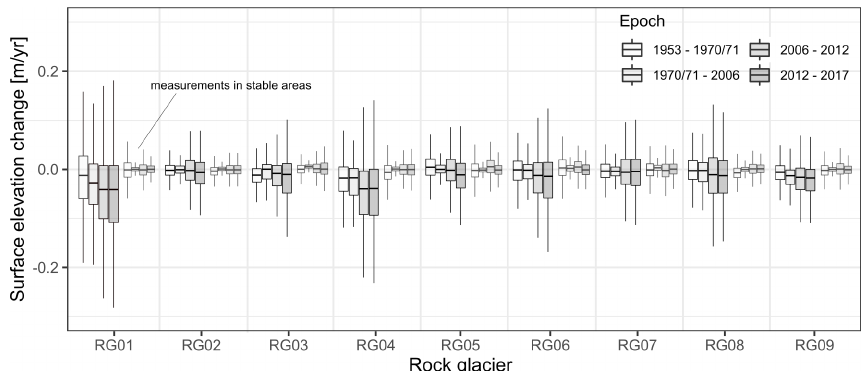
Figure 8. Boxplots showing annual surface elevation changes on the single rock glaciers and corresponding stable areas (greyed out) for the four epochs between 1953 and 2017.